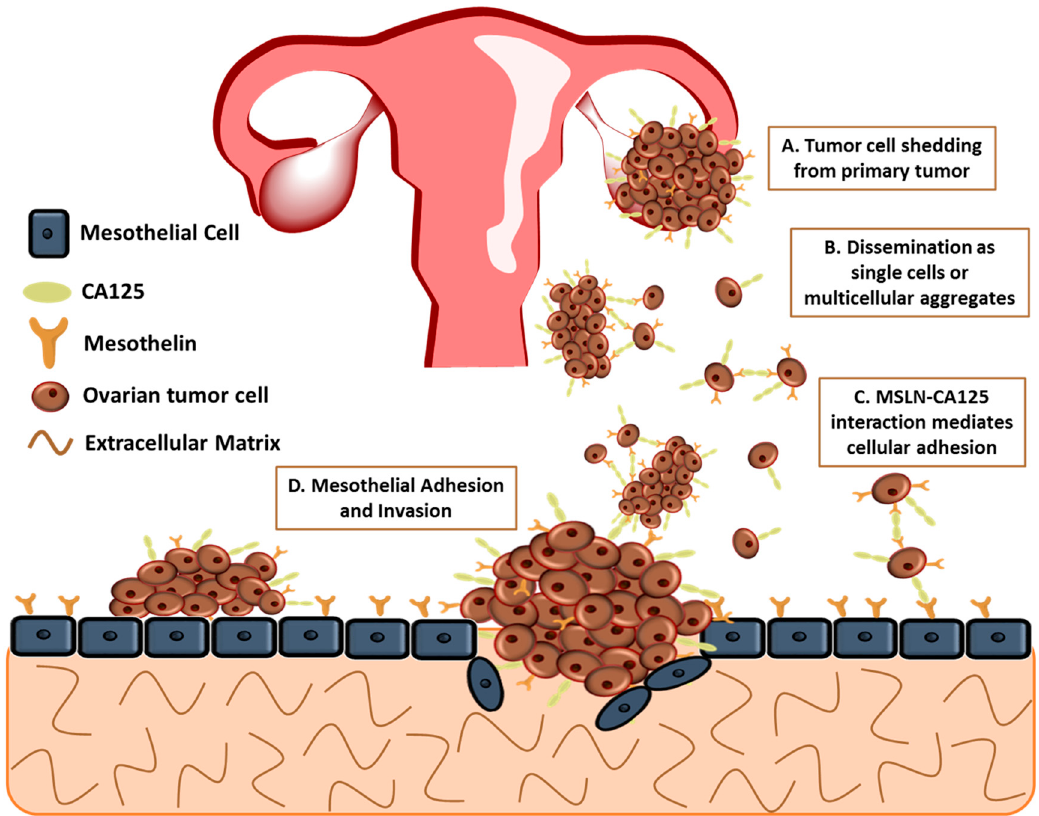
Figure 1. Model for peritoneal metastasis of ovarian tumors. Ovarian cancer metastasis is unique as tumor cells shed from the primary tumor and spread throughout the peritoneal cavity. MSLN:CA125 interaction mediates heterotypic and homotypic cellular adhesion.